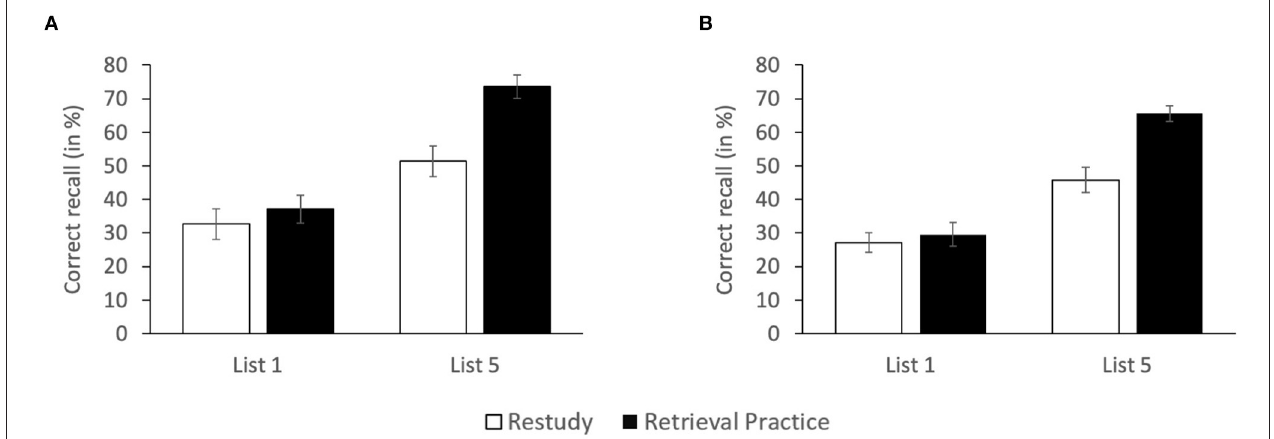
FIGURE 2 | Recall rates of first-list and last-list (list 5) items as a function of PRACTICE for (A) unrelated study lists (Experiment 2a) and (B) categorized study lists (Experiment 2b) Error bars reflect standard errors.